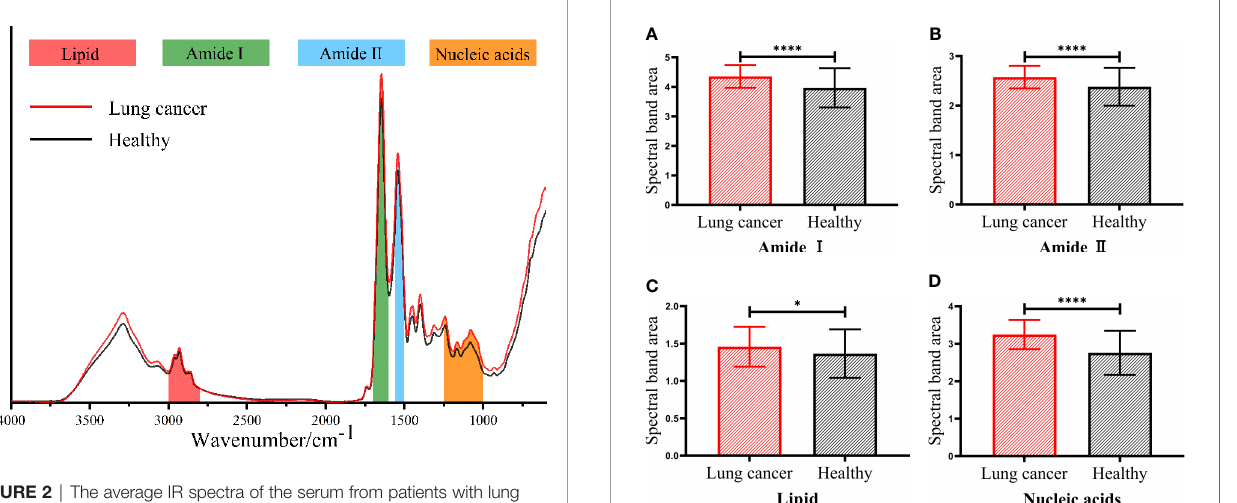
FIGURE 2 | The average IR spectra of the serum from patients with lung cancer and healthy